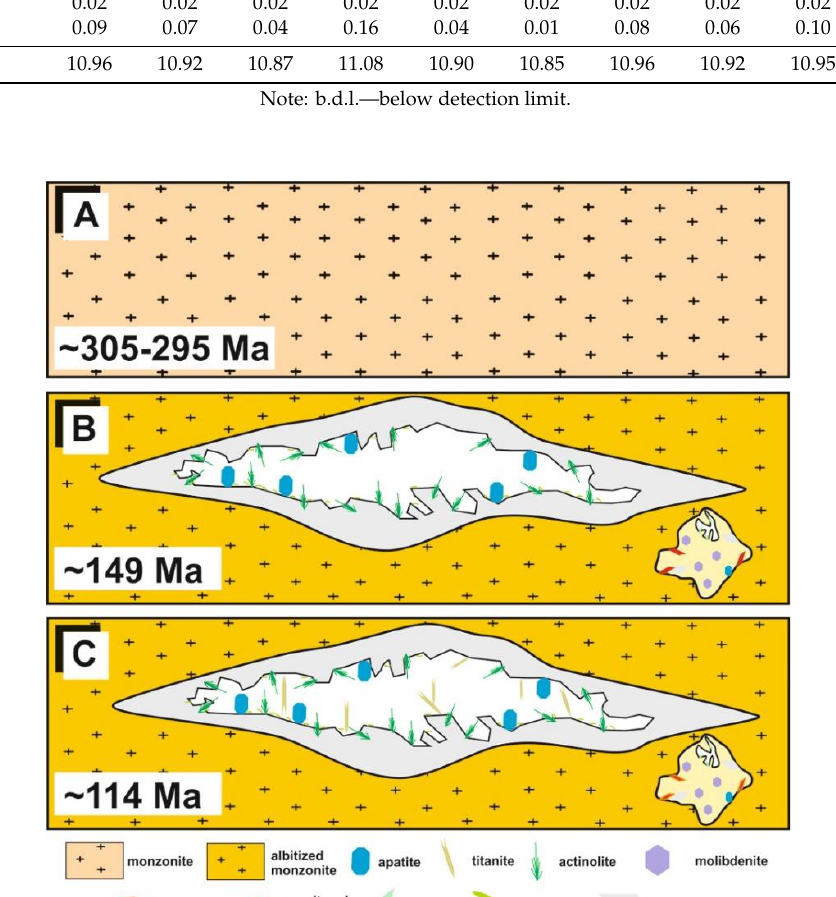
O = F Total Si (a.p.f.u.)